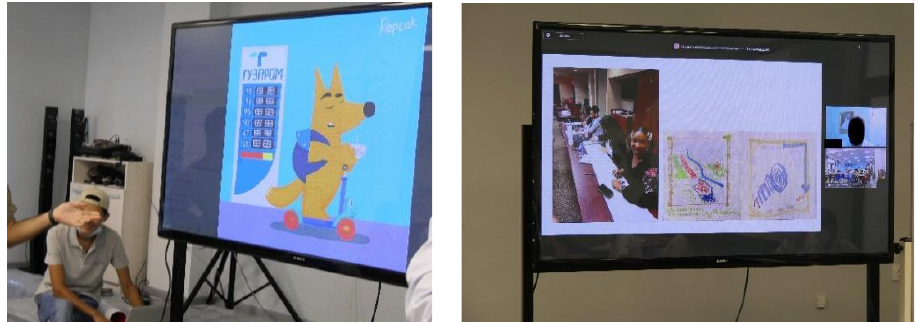
Figure 7. ( a ) The Young Generation of Tajikistan staff lead the participants through the drawing and storytelling workshop; ( b ) The workshop begins with a translated videotelephony lecture on drawing and place by the author, translated by the YGT workshop leaders (courtesy of the Young Generation of Tajikistan).